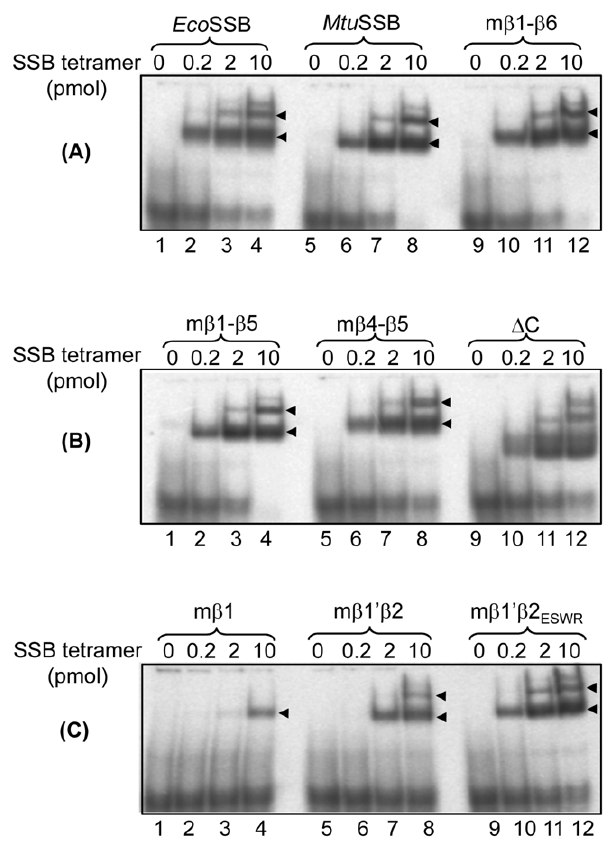
Figure 4. Electrophoretic mobility shift assays using 32 P labeled 79mer ssDNA. DNA (1 pmol) was mixed with 0.2 pmol (lanes 2, 6 and 10); 2 pmol (lanes 3,7 and 11) and 10 pmol (lanes 4, 8 and 12) of SSBs (as indicated) for 30 min and analyzed on native PAGE (8%).